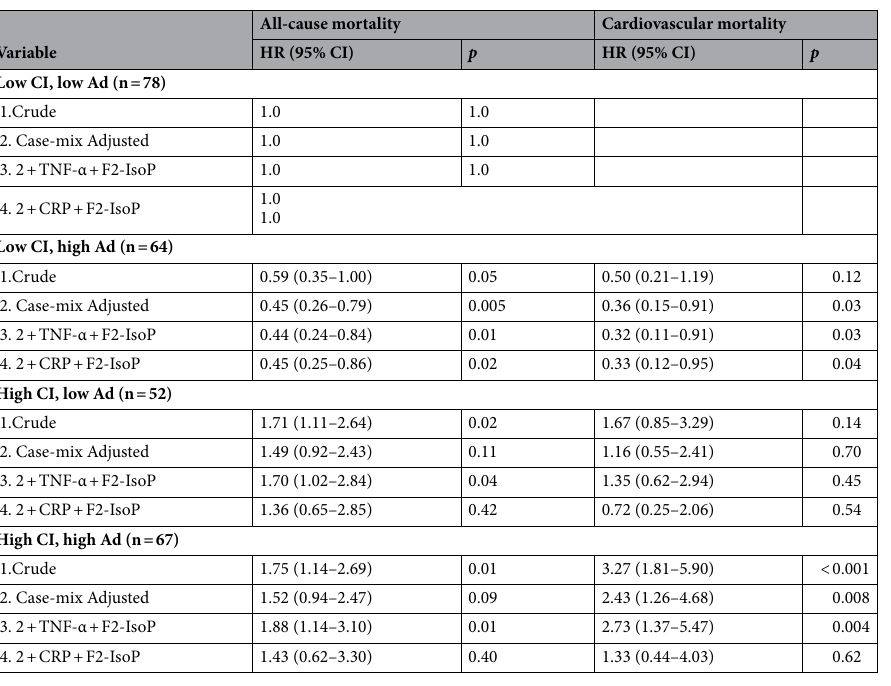
Table 4. Crude and adjusted all-cause and CVD-related mortality grouped according to CI and adiponectin levels a in the study population (n = 261). Case-mix—adjusted for age, gender, diabetes status, dialysis vintage, residual renal function, smoking, Kt/V and FMI. All variables included in the regression models are continuous except for categorical variables. Abbreviations: CI, comorbidity index; HR, hazard ratio; CVD, cardiovascular disease; Ad, adiponectin; F2-IsoP, F2-isoprostanes. a The group of patients who had low CI (defined as CI levels below median) and low adiponectin (defined as adiponectin levels below median) was used as a